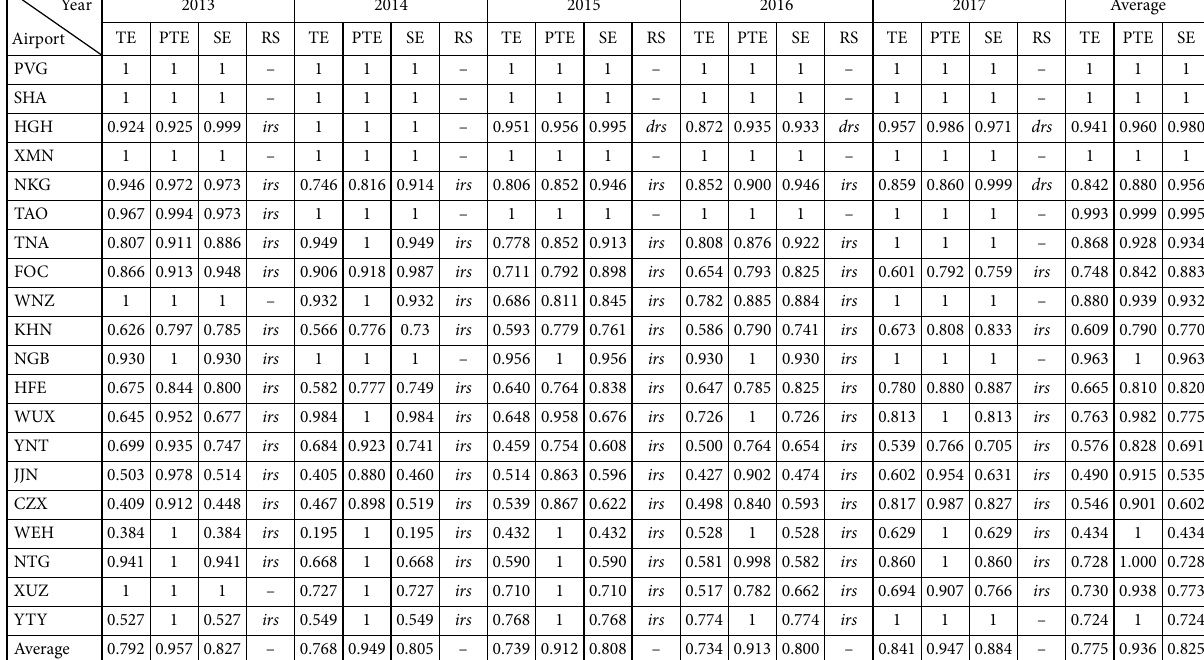
Figure 3. Average TEs of five years of 20 airports in the third Table 6. Efficiency of the third stage